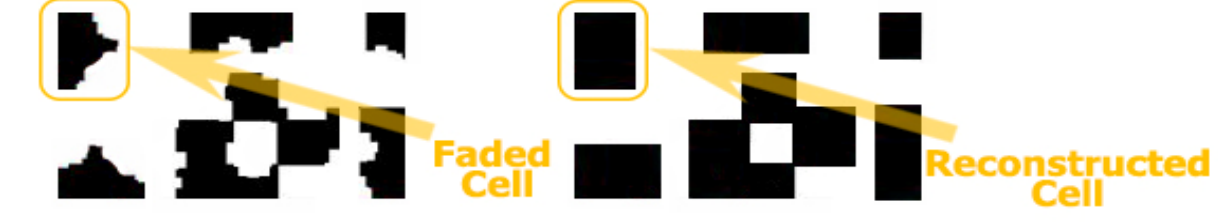
Figure 12. Before and after the process of constraining a data set (quantization).